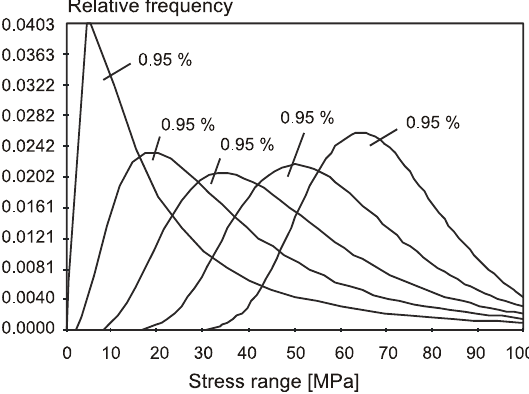
Fig. 5. Lognormal density function of stress range